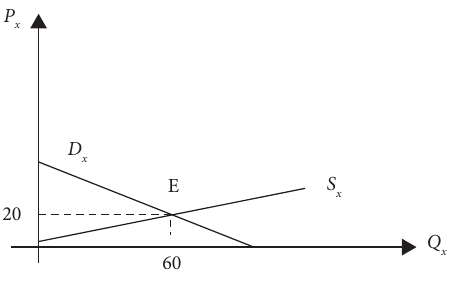
Figure 4: Te generated balance